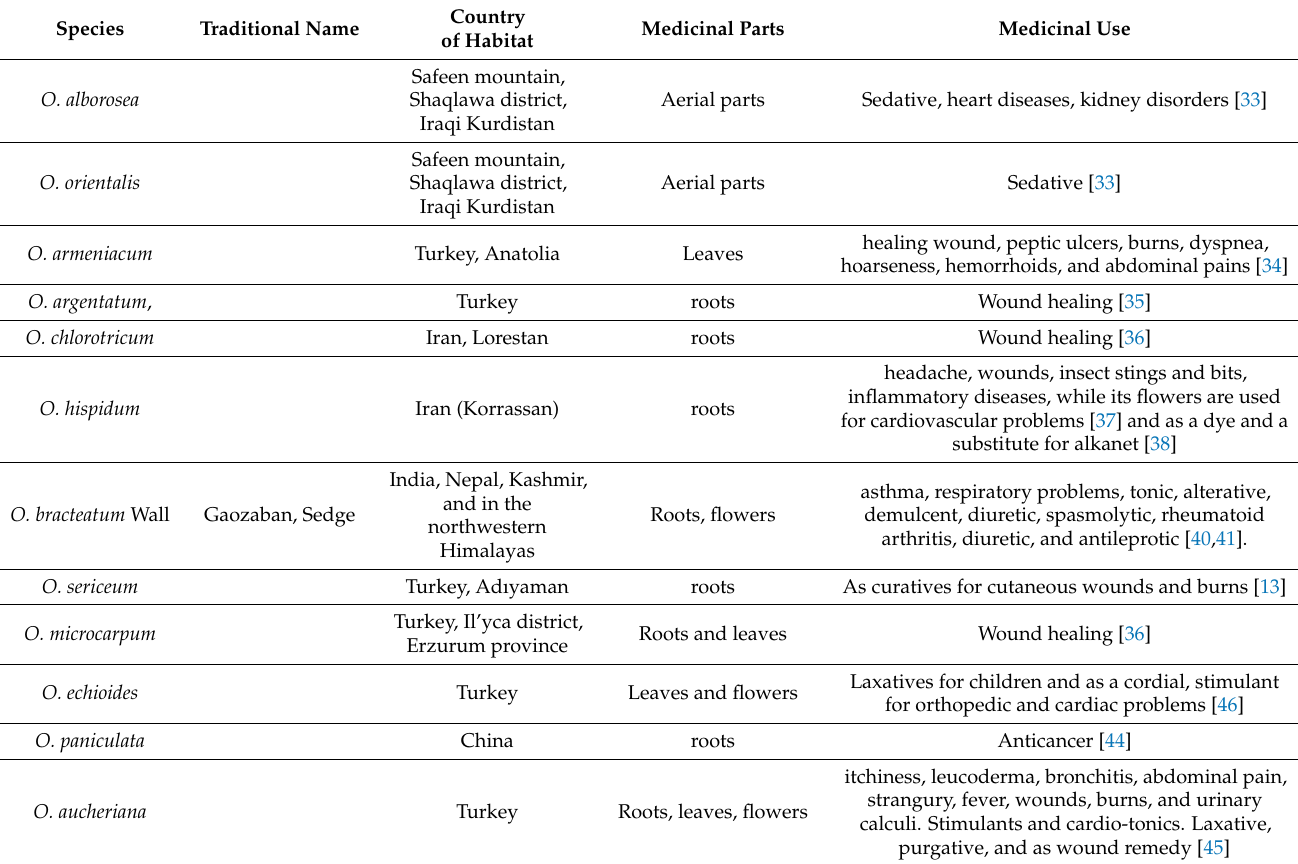
Table 2. The traditional use of Onosma medicinal